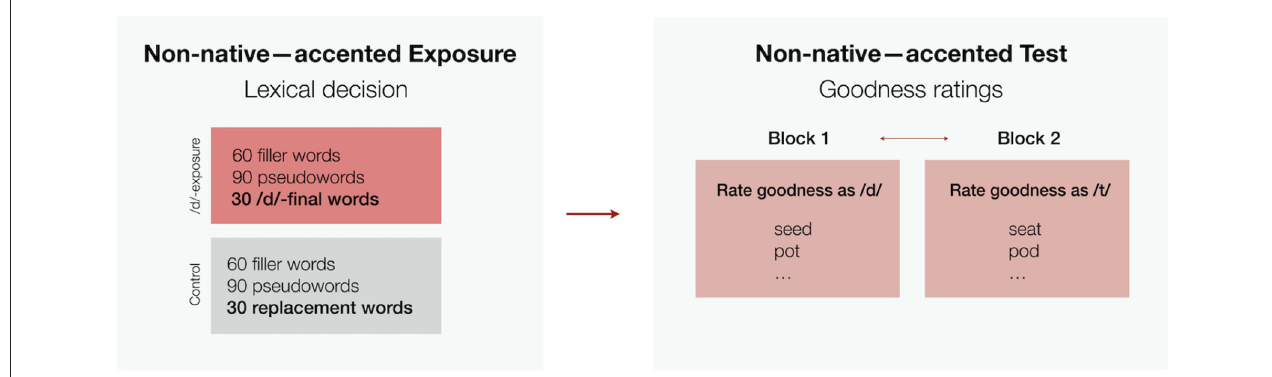
FIGURE 1 | Design of English and Swedish experiment analyzed here. The order of /d/- and /t/-goodness test blocks was counter-balanced across